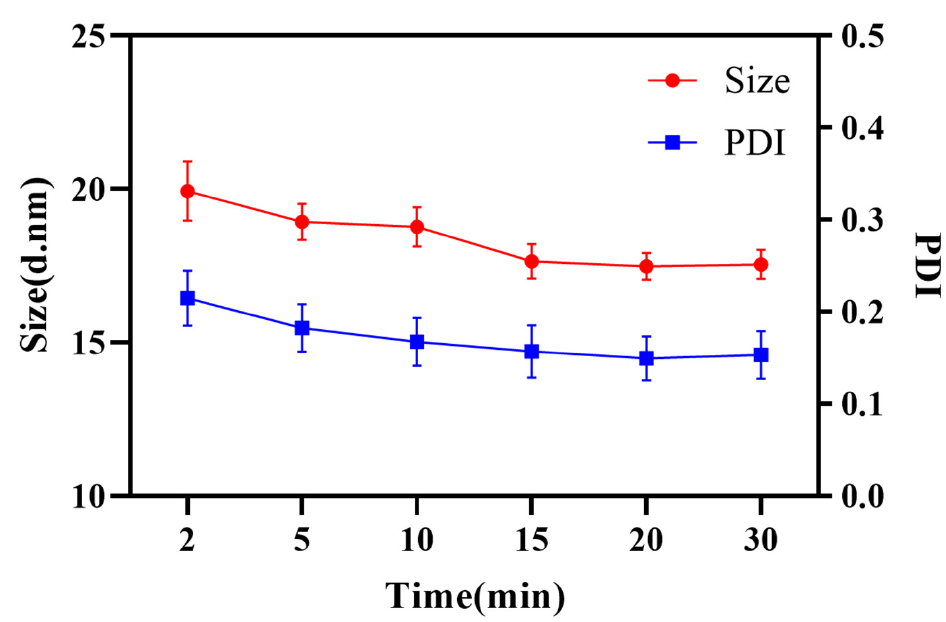
Figure 6. Droplet size and PDI at different emulsification times.